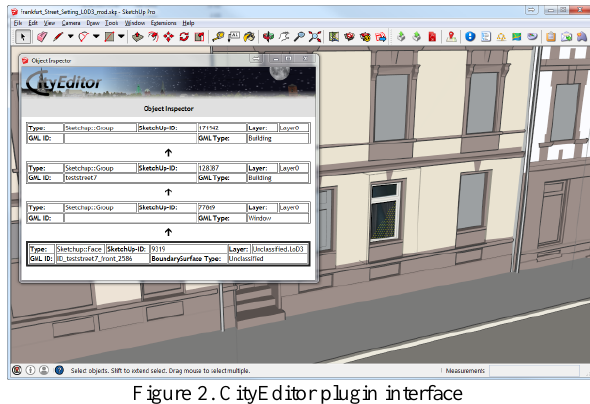
Figure 2. CityEditor plugin interface